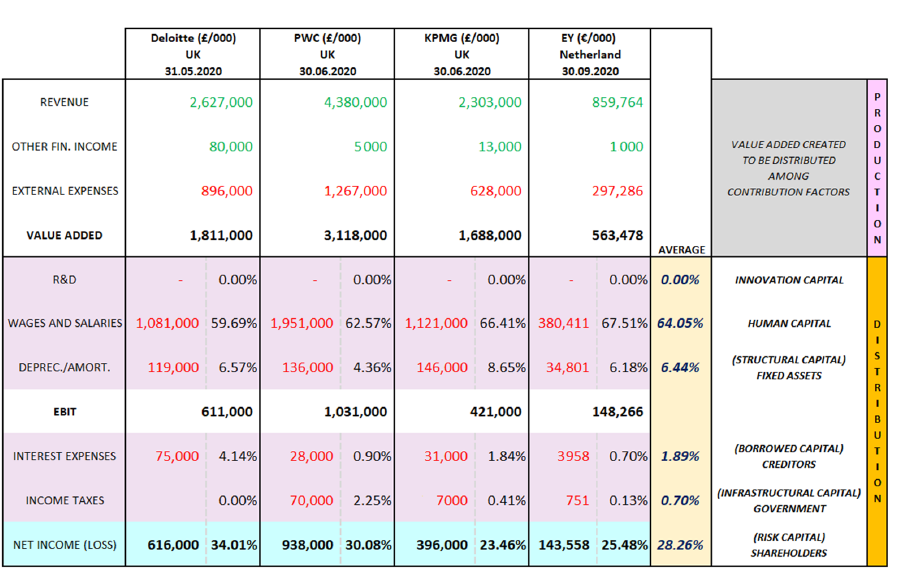
Figure 3. Big Four audit companies’ value ‐ added income statements 2020 (European branches only).